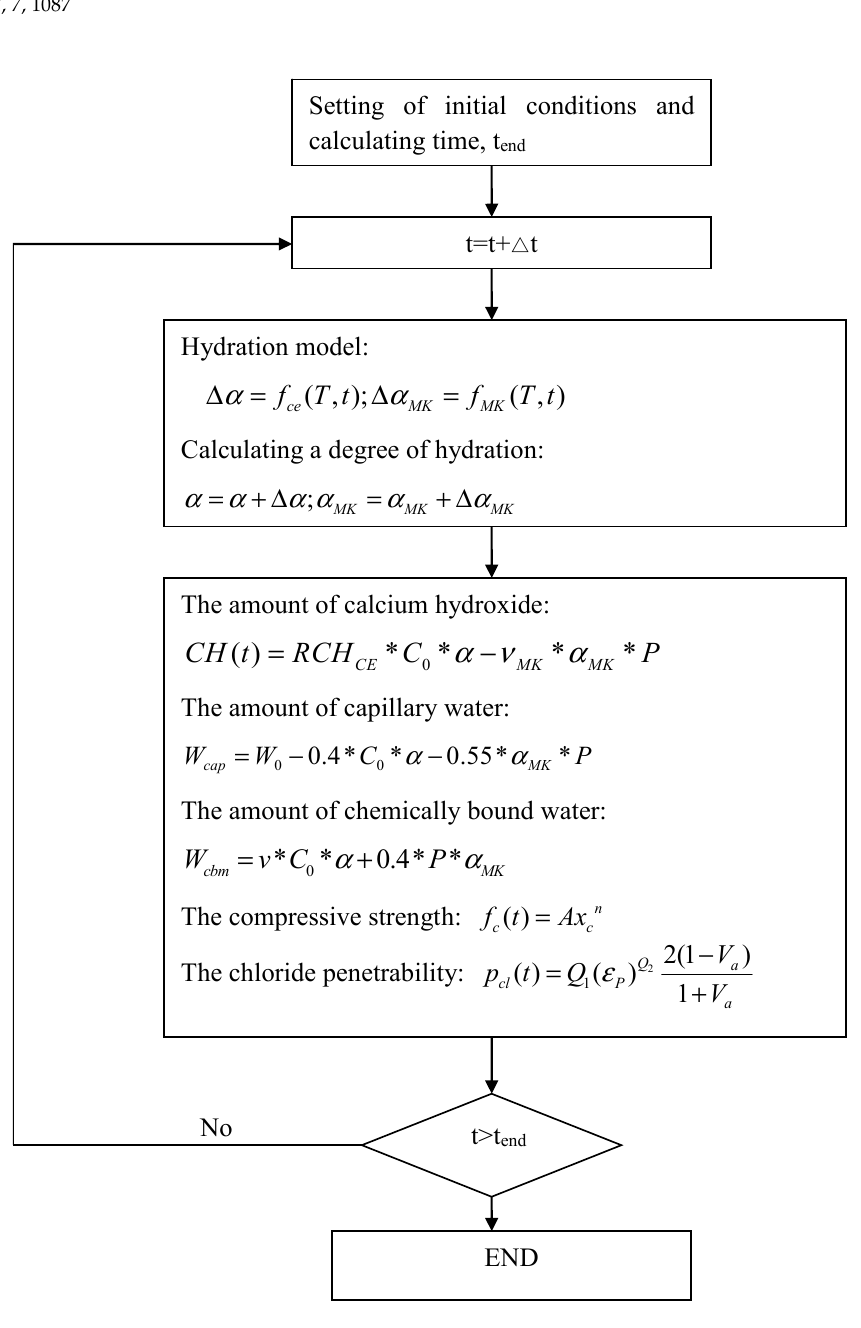
Figure 1. Flowchart of calculation.